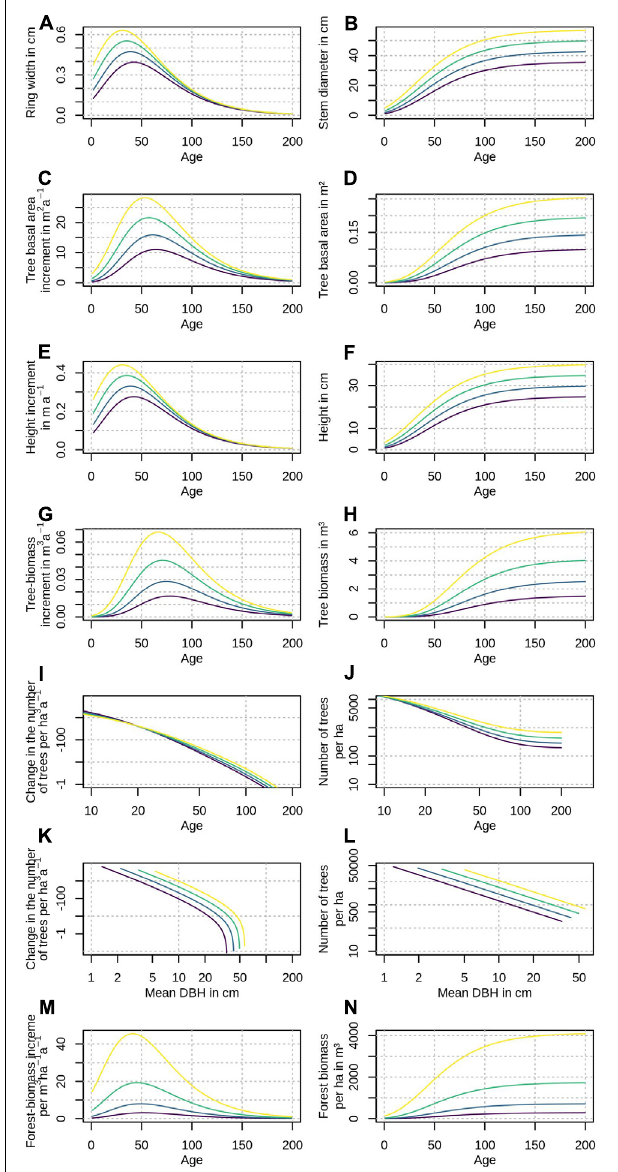
FIGURE 1 | Various types of idealized growth rates show how different tree and forests parameters change with age and stem diameter. Different colors represent better (yellow) or worse (purple) growth conditions. Different disciplines use different growth-rate types to explore trends, for example, changes in stem diameter or basal area (A–D) , changes in tree height at a given age (yield tables in forestry: E,F ), self-thinning lines (I–L) , and tree-biomass or wood volume increment (G,H,M,N)